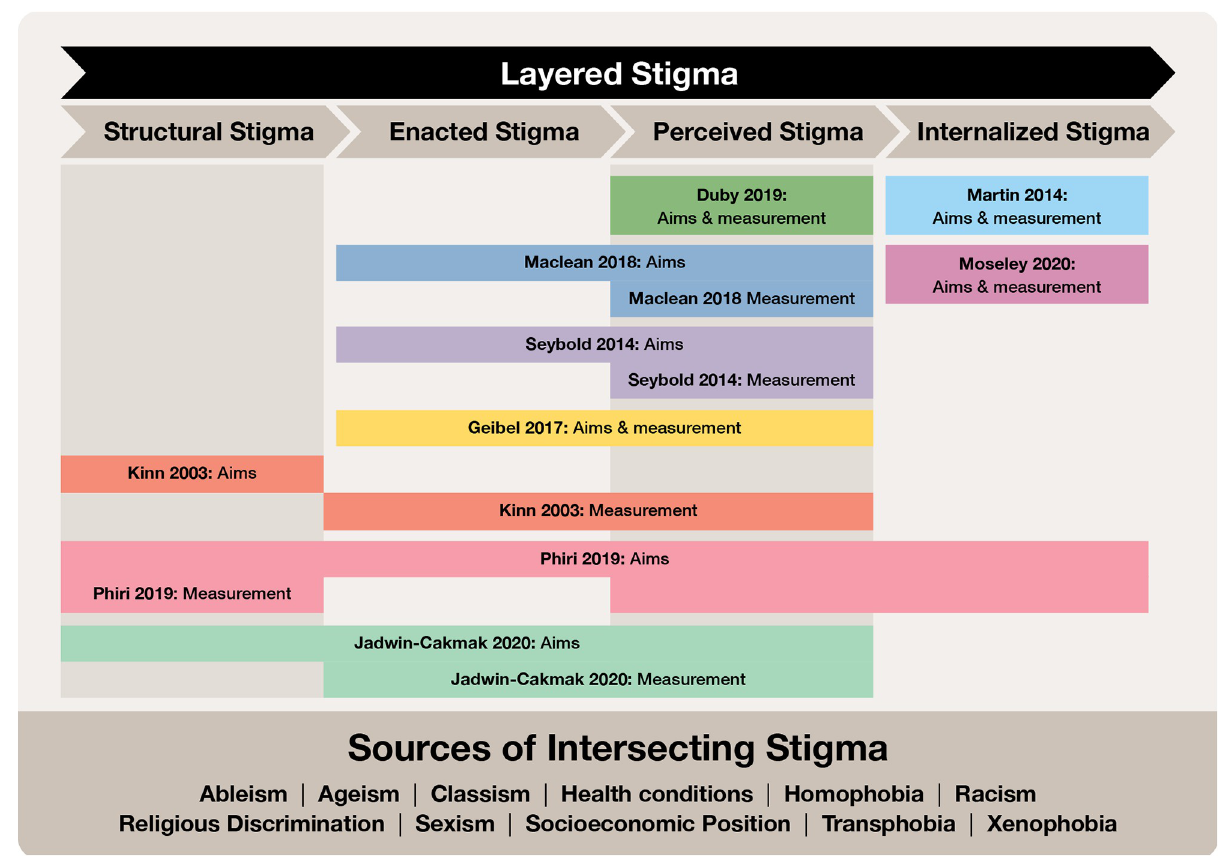
Fig 4. Mapping included intervention aims and outcome measures using a multi-level stigma model. This figure depicts a mapping of the nine studies with relevant quantitative outcomes on stigma or discrimination to the different levels at which stigma can exist and be confronted. First, we mapped the studies based on which level or levels of stigma (internalized, perceived, enacted, structural, layered) the strategies aimed to address and how they were measured (Tables 1 and 2). Where strategies aimed to address or measure across more than one level of stigma, we indicated as such. Then we visually mapped the strategy aims and measurement approaches across the different levels of stigma to explore where the aims and measurement approaches were similar and different.